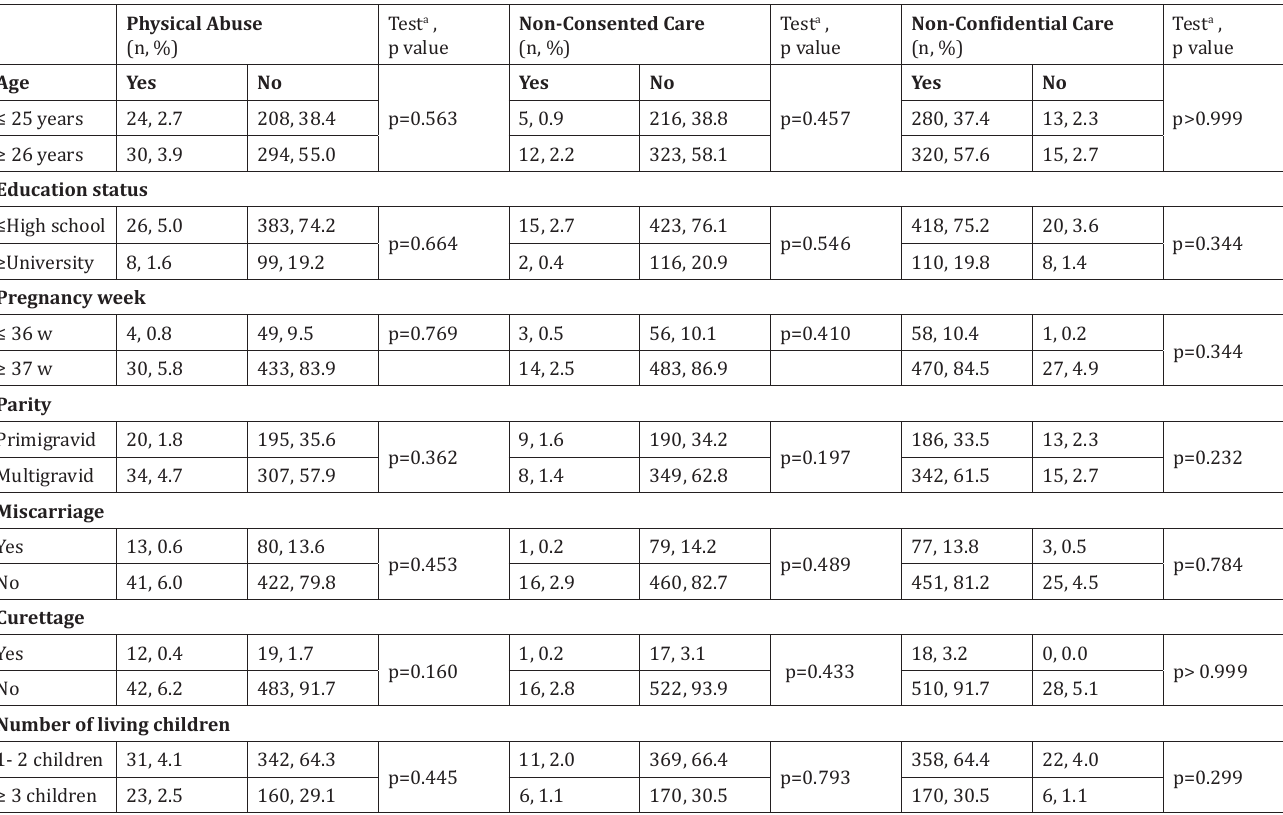
The distribution of women according to their exposure to physical abuse, non-consented care and non- Table 6 confidential care according to some sociodemographic and obstetric